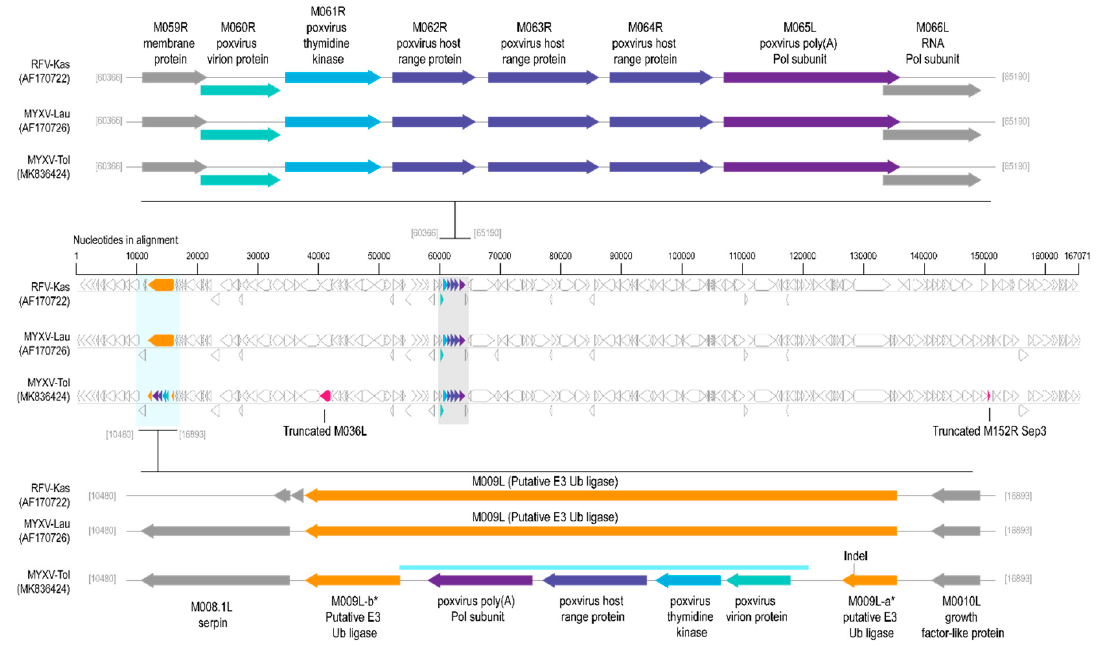
Figure 2. Representation of the aligned genome organization of both RFV-Kas (AF170722), MYXV-Lau (AF170726), and Myxoma virus-Toledo (MYXV-Tol) (MK836424). Blue ORF illustrations represent truncated genes; purple shows the location of M060R , M061R , M062R , M063R , M064R , and M065R genes in both MYXV virus; orange shows the M009L gene (intact in RFV-Kas, MYXV-Lau, and disrupted in MYXV-Tol) and shades of blue represent the new gene “cassette” identified in MYXV-Tol, which is highly likely derived from a recombinant event with an unsampled poxvirus.